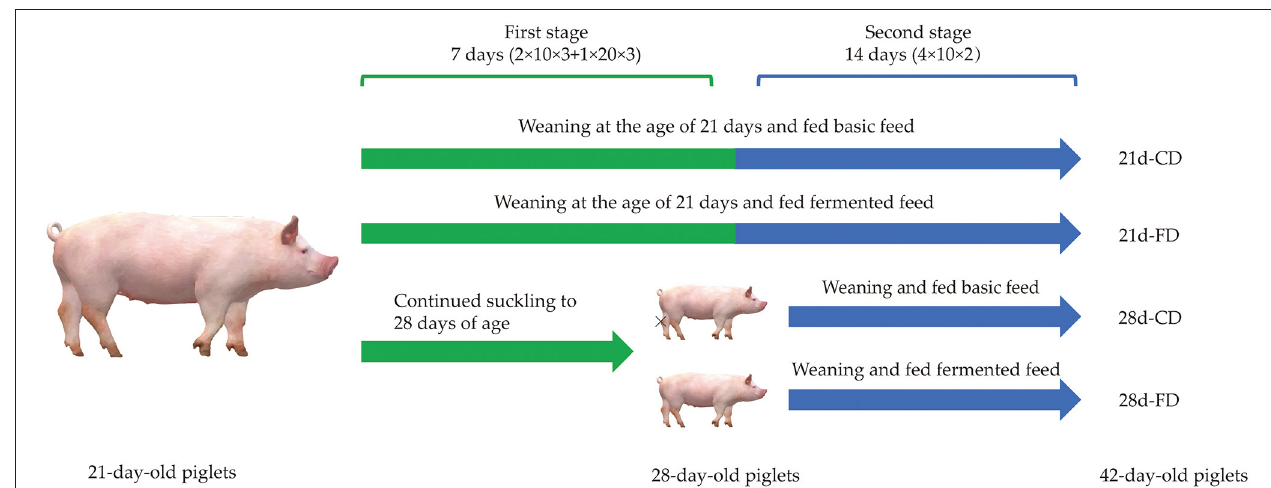
Frontiers in Veterinary Science |